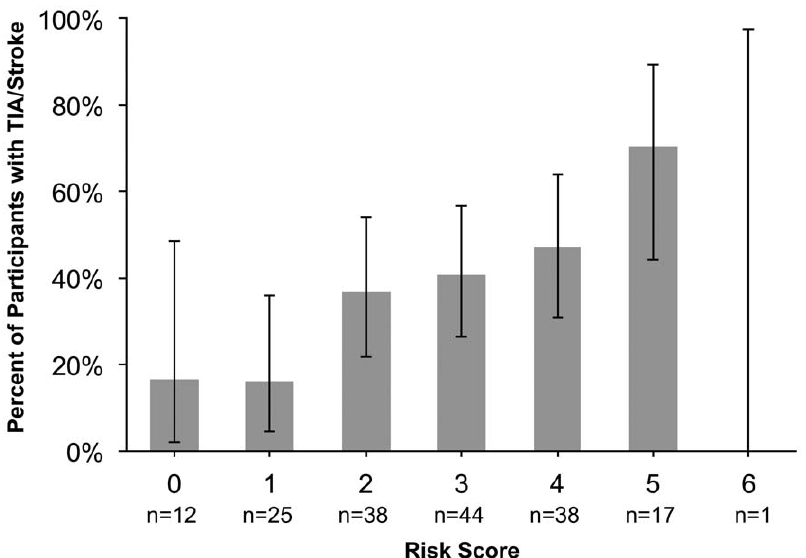
Figure 1. Percent of participants with transient ischemic attack or stroke by self-reported ABCD 2 score. A modified ABCD 2 score was calculated from self-reported components of the score (age . =60=1 point; Clinical Features: Speech Disturbance without weakness=1 point, Unilateral Weakness=2 points; Duration: 10–59 minutes=1 point, . 60 minutes=2 points; Diabetes=1 point). The blood pressure item was excluded since this was not likely to be available by self-report, so the range of this risk score was 0 to 6. The grey bars show the proportion observed and the black vertical lines represent the 95% confidence interval around that proportion. The one enrollee with a score of 6 had migraine.